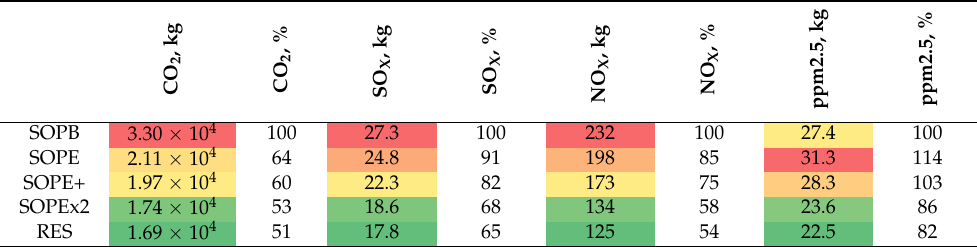
Table 7. Target emissions of the SustainHuts project in all the observed configurations in the Lizara hut.